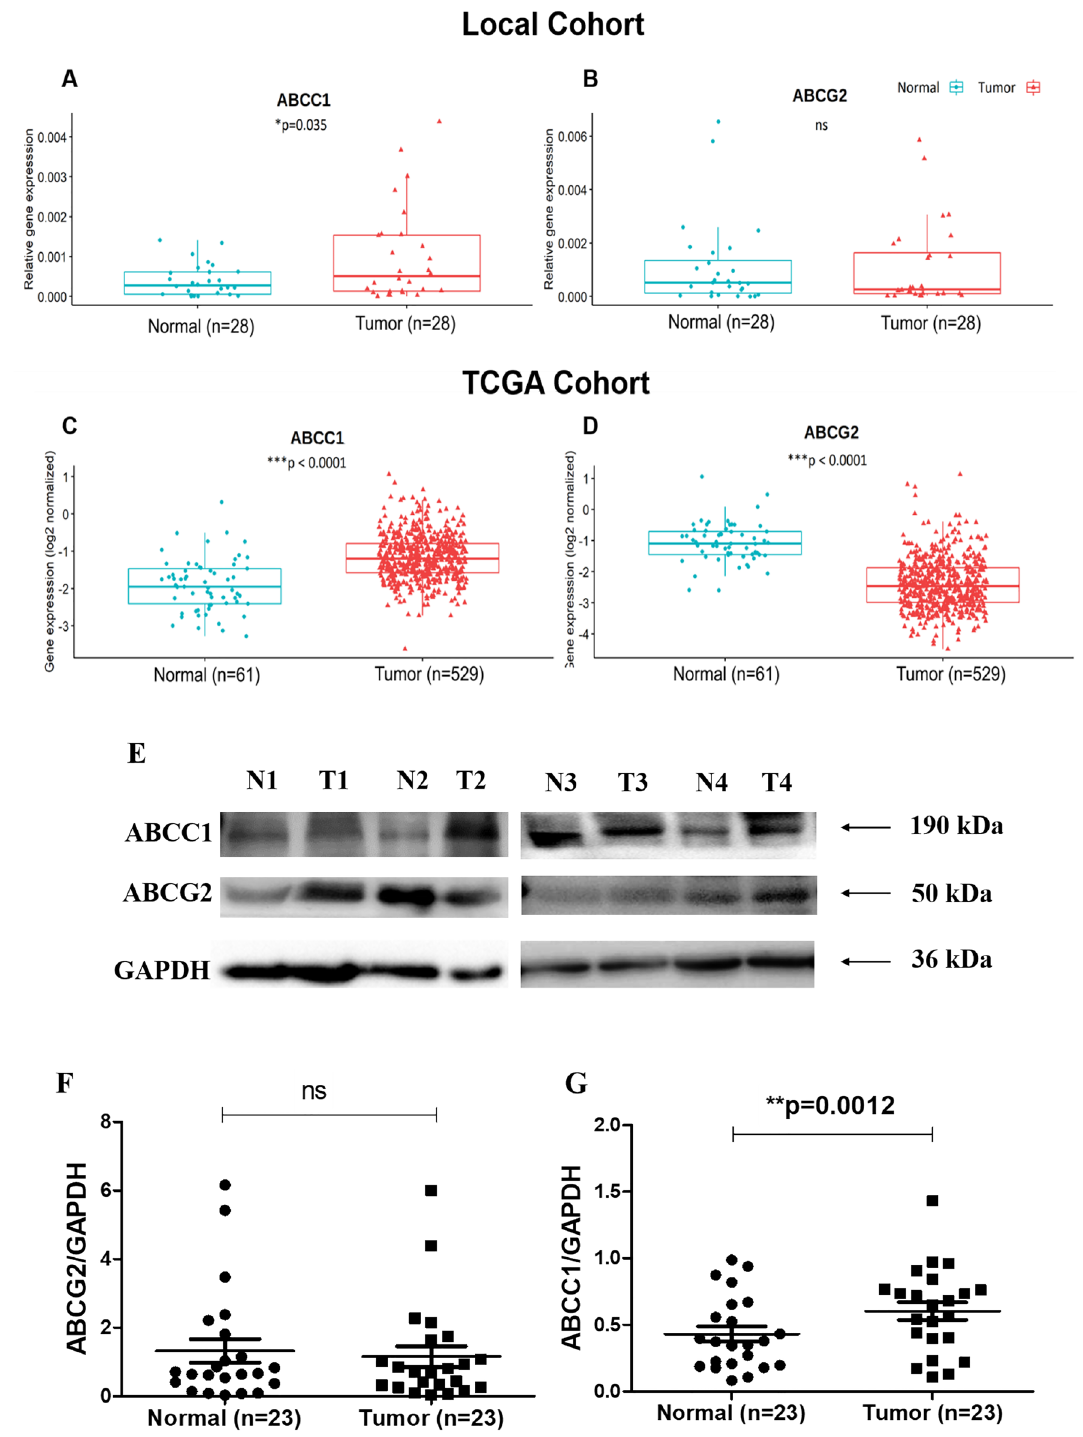
Figure 9. ( A – D ) Gene expression of drug transporters in breast cancer patients ( A ) ABCC1 , ( B ) ABCG2 in local cohort ( C ) ABCC1 , ( D ) ABCG2 in TCGA cohort and ( E – G ) Protein expression of drug transporters ( E ) Representative blots in adjacent normal (N) and tumor (T) tissues, ( F ) Densitometric analysis of ABCG2 and ( G ) ABCC1 levels in adjacent normal and tumor